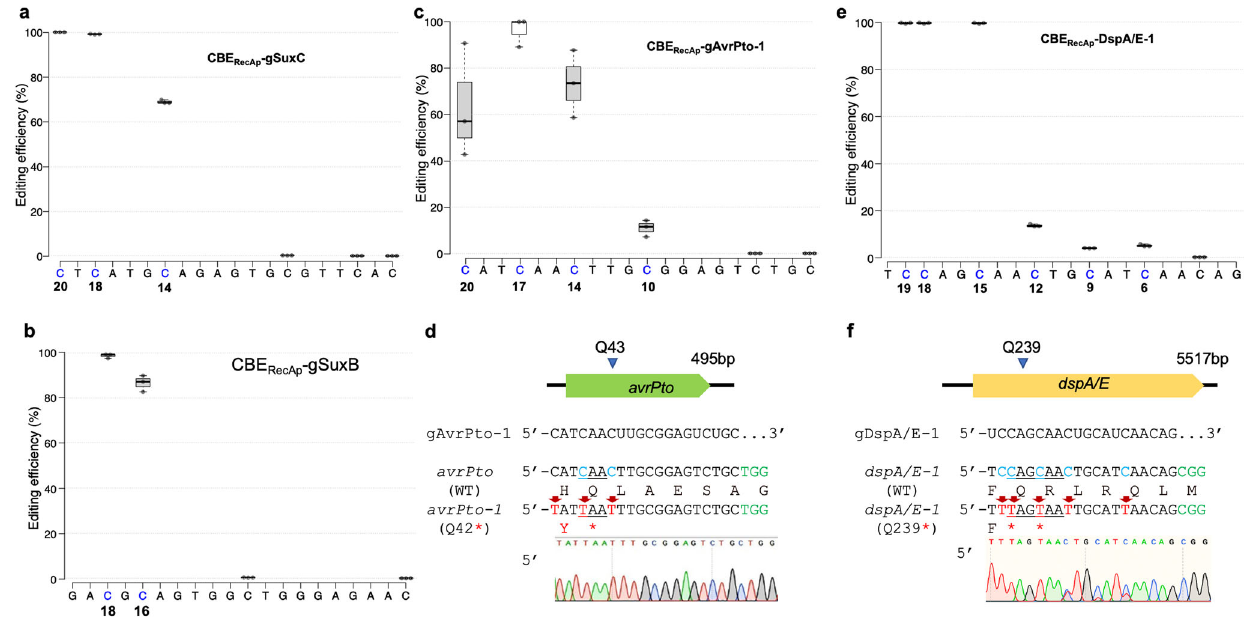
Fig. 2 Ef fi cient base editing in Xanthomonas, Pseudomonas and Erwinia . a Quanti fi cation of the C to T editing before curing for gSuxC in PXO99 A . dCas9- CDA1-UGI was driven by promoter RecAp. The percentage of C to T conversion is based on the deep sequencing analysis. Edited C ’ s in the protospacer are indicated by blue color with the numbers for the positions relative to PAM. b Quanti fi cation of the C to T editing before curing for gSuxB in PXO99 A . The percentage of C to T conversion is based on the deep sequencing analysis of PCR-amplicons of target regions. c Quanti fi cation of the C to T editing before curing for gAvrPto-1 in Pseudomonas DC3000. dCas9-CDA1-UGI was under control of promoter RecA . d Base editing outcomes after eviction of editor. e Quanti fi cation of the C to T editing before curing for gDspA/E-1 in Erwinia Ea9. dCas9-CDA1-UGI was under control of promoter RecA . f Base editing outcomes after eviction of